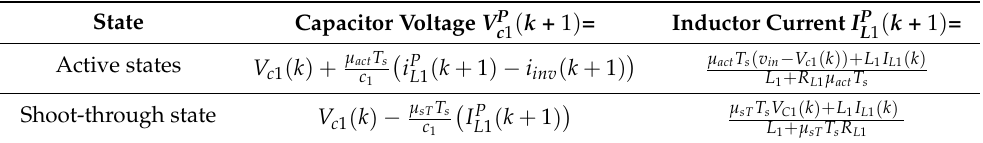
Table 2. Prediction of control states with modulation